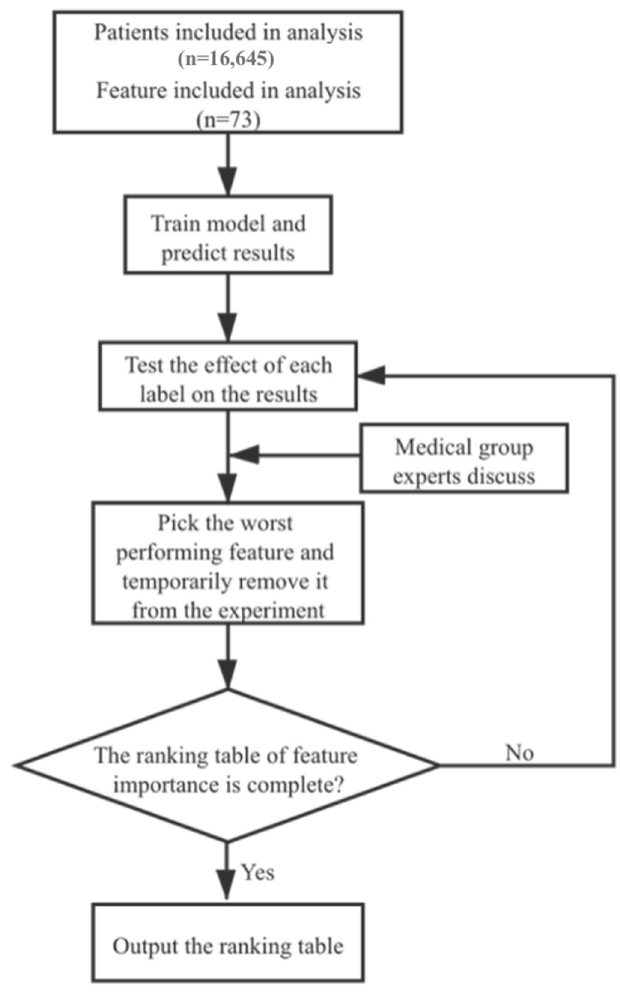
Figure 2. Flowchart of feature selection.